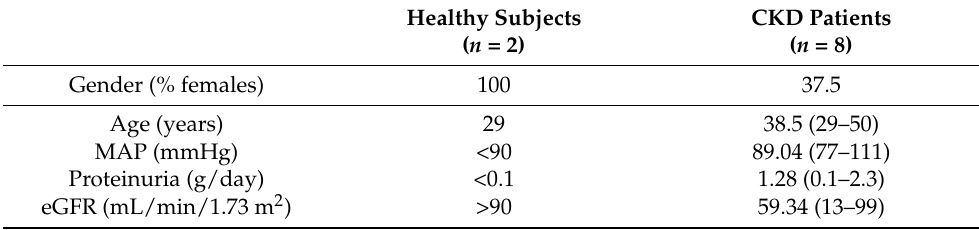
Table 3. Clinical information of the study population. The mean values (ranges) are provided.